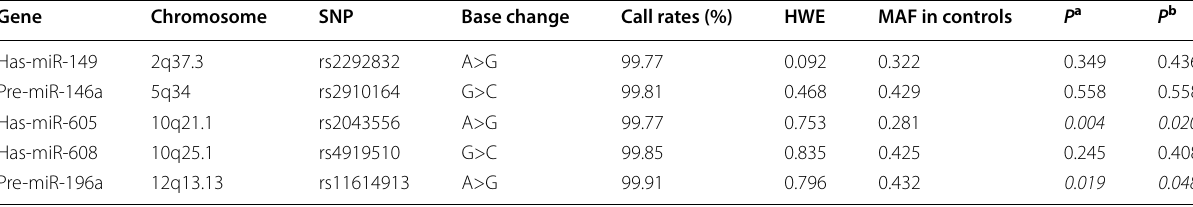
Italic value indicate significance of p value ( p < 0.05) HWE Hardy–Weinberg equilibrium, MAF minor allele frequency a Two-sided Chi squared test for the comparison of the allele frequency between HNSCC patients and cancer-free controls b P values adjusted by false discovery rate (FDR)